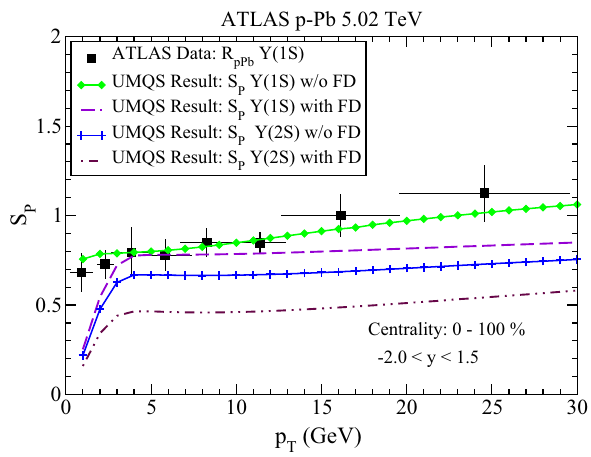
Fig. 11 Survival probability of ϒ( 1 S ) versus p T is compared with ϒ( 1 S ) nuclear modification factor R s NN = 5 . 02 TeV. S P of ϒ( 2 S ) is predicted for same collision system